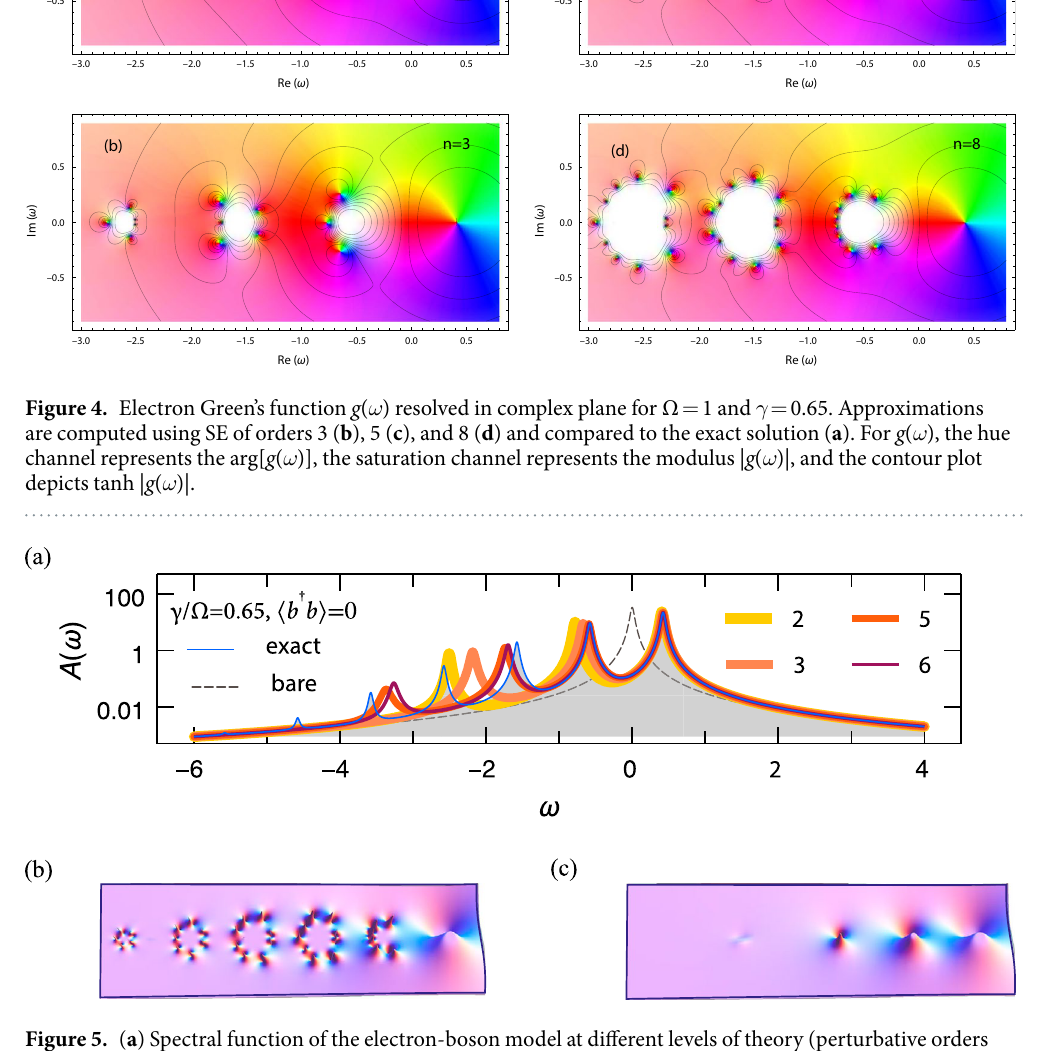
Figure 5. ( a ) Spectral function of the electron-boson model at different levels of theory (perturbative orders n = 2, … , 6 are denoted by different line styles) for the following values of parameters:  = 0, Ω = 1, γ = 0.65, η = 0.03. The effect of Pade regularization is depicted in the two panels below: ( b ) no PA is applied, the higher- order poles are visible; ( c ) the regularized spectral function contains only simple